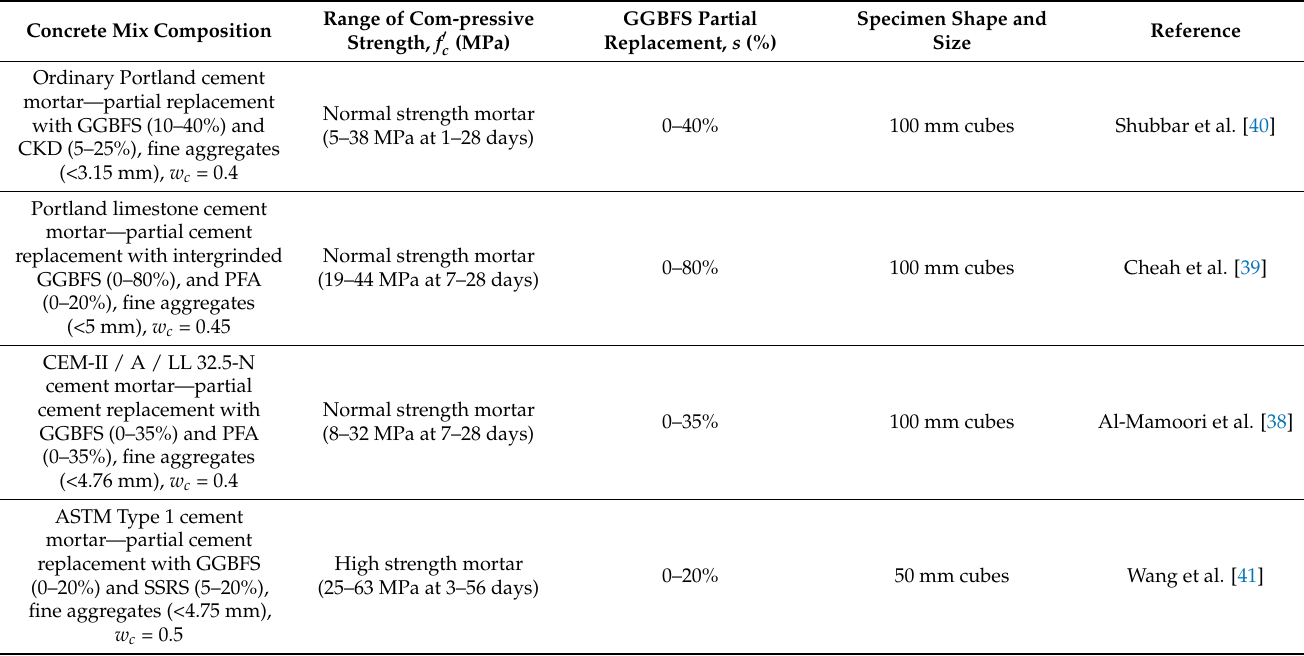
Table 6. Previous studies on slag blended mortars.